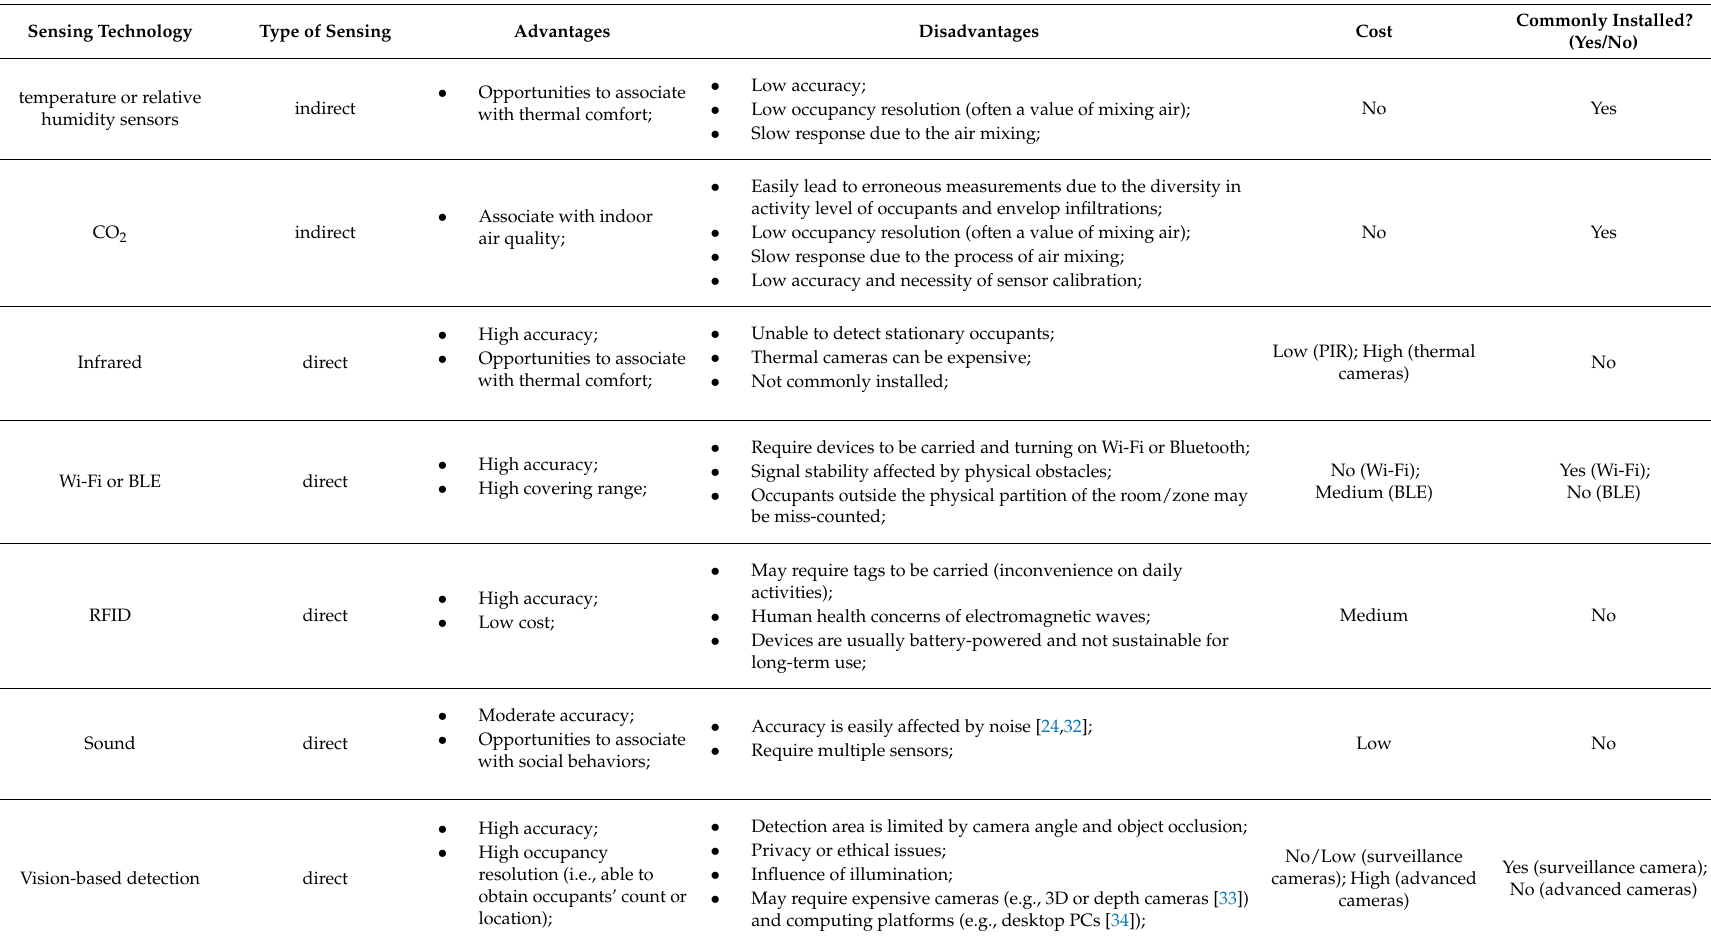
Table 1. Characteristics of different occupancy detection